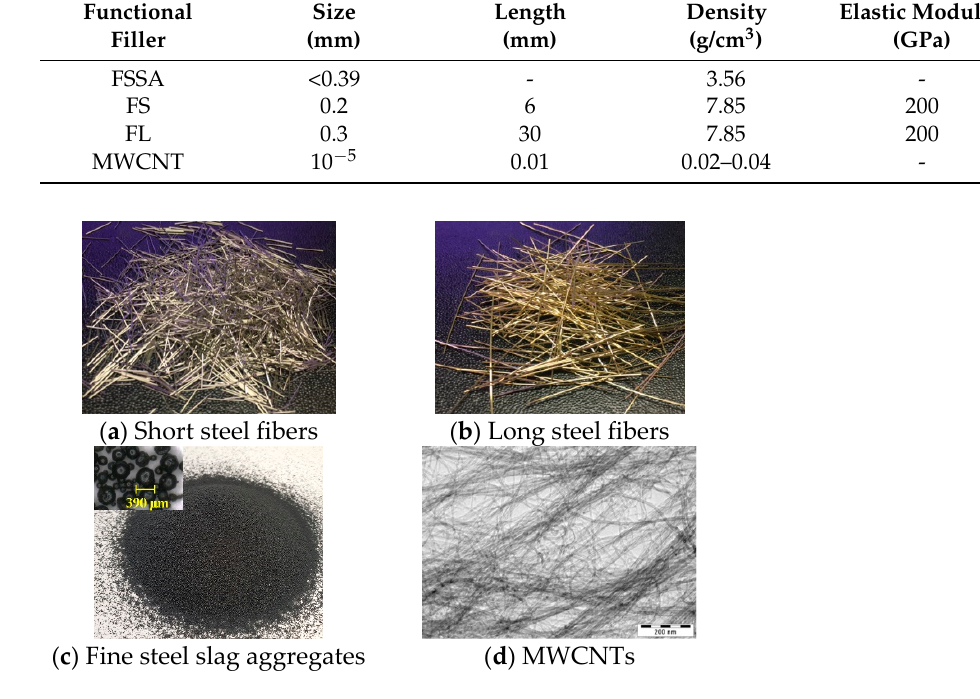
Figure 6. Images of the functional fillers.